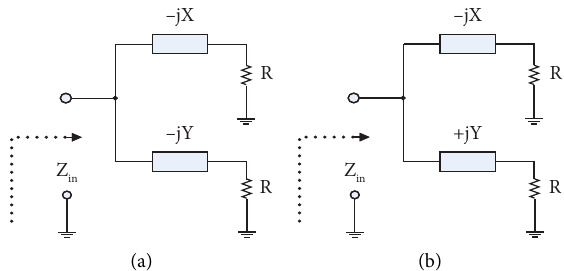
Figure 10: Te another modifed RCN (changing the amplitude or